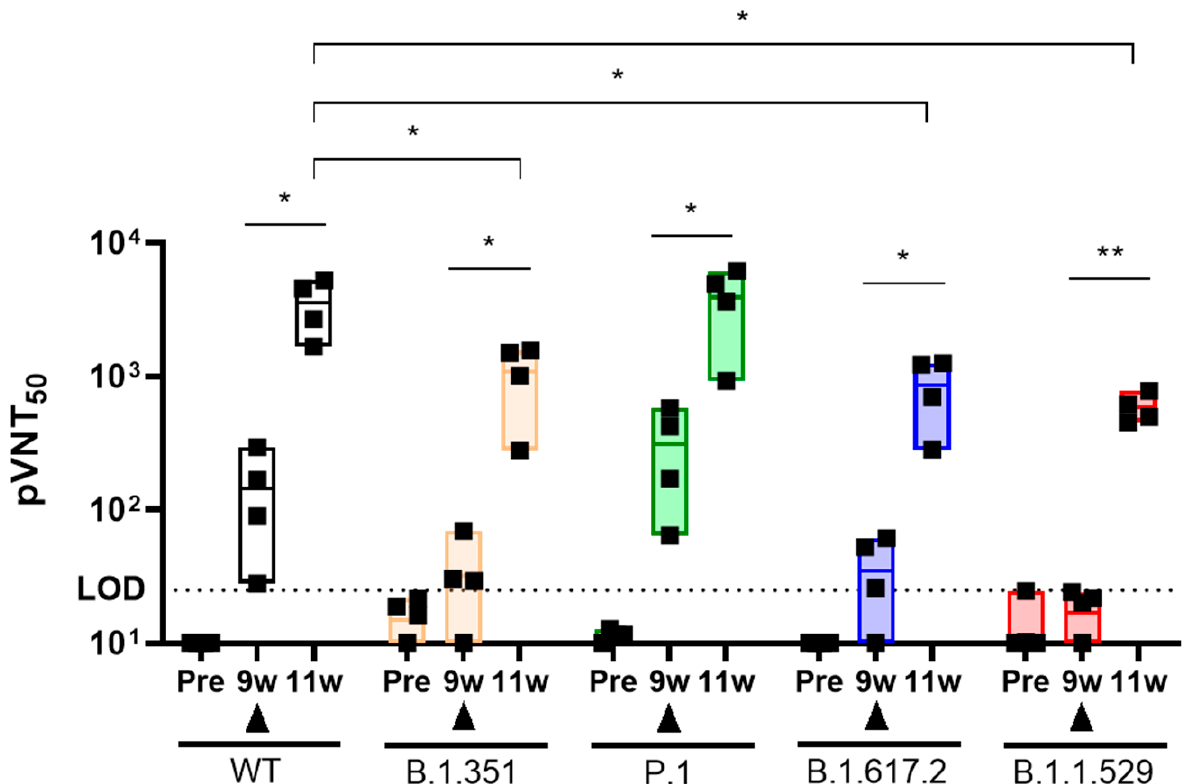
Figure 6. Booster shot evaluation of AdCLD-CoV19-1. ( a ) NHPs were immunized by AdCLD-CoV19-1 (2 × 10 10 VP) once intramuscularly, followed by booster injections at the same dose at 9 weeks. Immunized sera from weeks 9 and 11 responded for 1 h with each variant (WT, B.1.351, P.1, B.1.617.2, B.1.1.529) pseudovirus (1 × 10 6 TU/mL). The neutralizing antibodies titer from the mixture